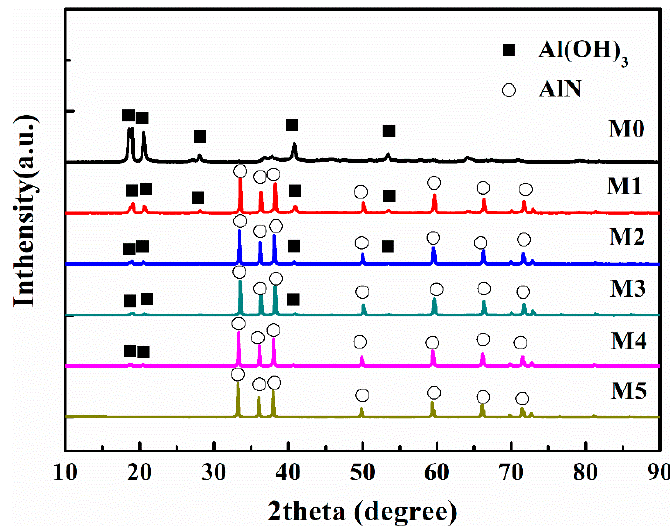
Figure 7. XRD pa tt erns of modi fi ed AlN powder in 25 °C for 72 h. Figure 7. XRD patterns of modified AlN powder in 25 ◦ C for 72 h.